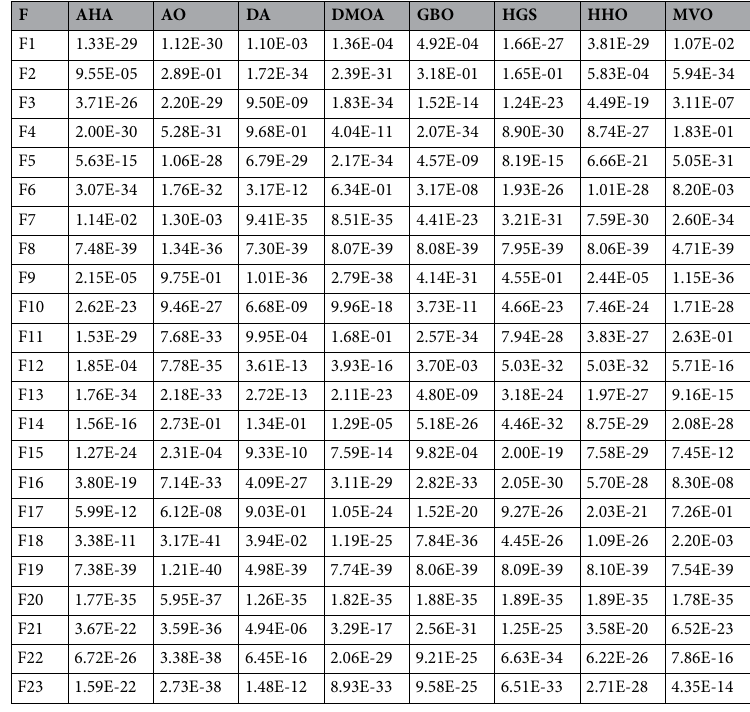
Table 8. The p- Values of the Wilcoxon rank-sum test over 23 benchmark functions.